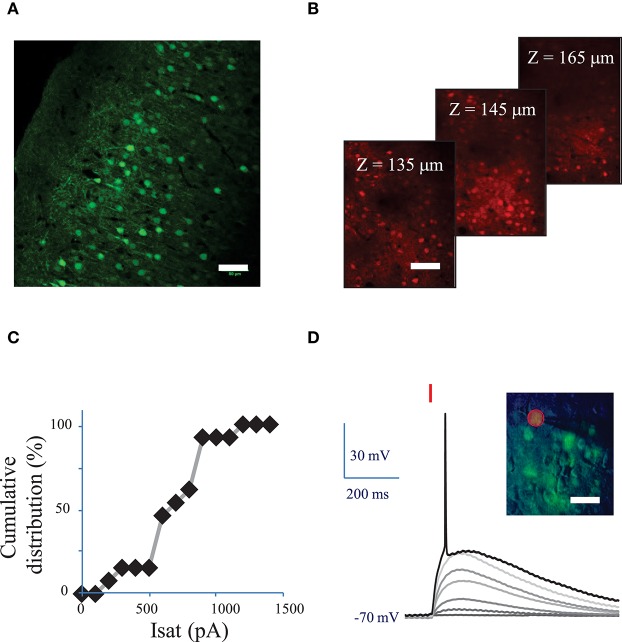
Conditions to evoke an action potential in neurons of mouse visual cortex Layer 2/3 with a fiber amplified Laser System at 1030 nm. (A) Maximum intensity projection of a z-stack of confocal images of a fixed sagittal brain slice from mouse injected with AAV1 CamKII-ReaChR-p2A-YFP, 2 weeks after injection. Scale bar: 50 μm. (B) 2P microscopy images of visual cortex layer 2/3 from an anesthetized mouse (1% isoflurane) injected with AAV1 Ef1α-ReaChR-p2A-dTomato, 7 weeks after injection. Scale bar: 50 μm. Selected images from a stack of 101 images (100 to 200 μm under the surface of the brain). (C) Cumulative distribution of the saturation current (in Methods see Section Voltage clamp measurements of currents evoked by photo-stimulation of opsins) generated by 2P holographic stimulation in L2/3 cells when cells were voltage-clamped at −70 mV. (D) Voltage response of a L2/3 pyramidal cell to a series of 10-ms long 2P holographic spots (15 μm diameter, over the cell soma) of constant Laser Power Density (LPD) (red bar). Steady state current injection was used to keep the cell voltage at −70 mV in resting conditions. The LPD was increased from 0 to 0.014 mW/μm2 within the series until an action potential (AP) was evoked. Inset: overlay of infrared (IR) slice image (grayscale), fluorescence (green) and 2P stimulation mask (red circled area) of V1 layer 2/3 in an acute sagittal brain slice from mouse injected with AAV1 CamKII-ReaChR-p2A-YFP, 5 weeks after injection. Scale bar: 30 μm.